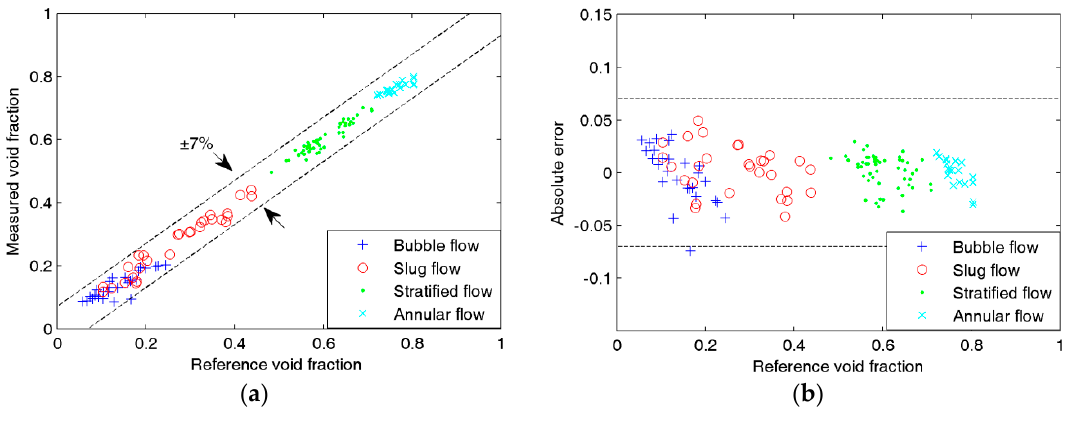
Figure 8. Experimental results of the void fraction measurement in the 4.22-mm i.d. channel: ( a ) Comparison between measured and reference void fractions; ( b ) Absolute errors of the void fraction measurement.